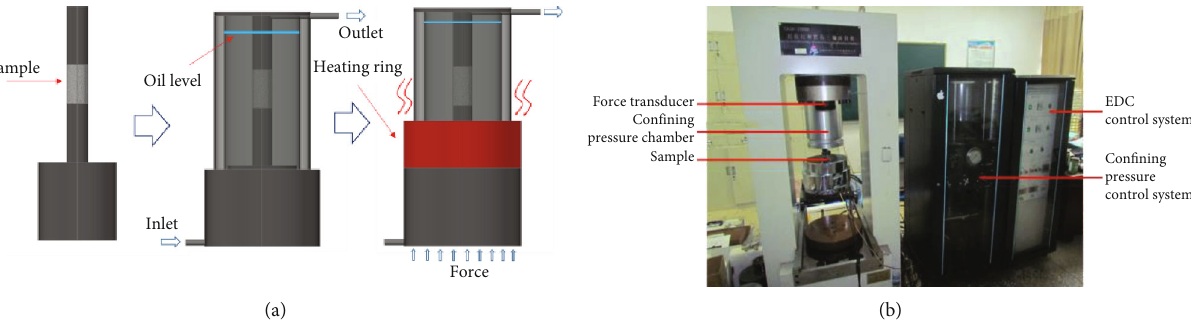
Figure 4: T-M coupled test principle diagram and triaxial testing machine: (a) Schematic diagram of the T-M coupled tests; (b) TAW-2000 servo-controlled rock triaxial testing